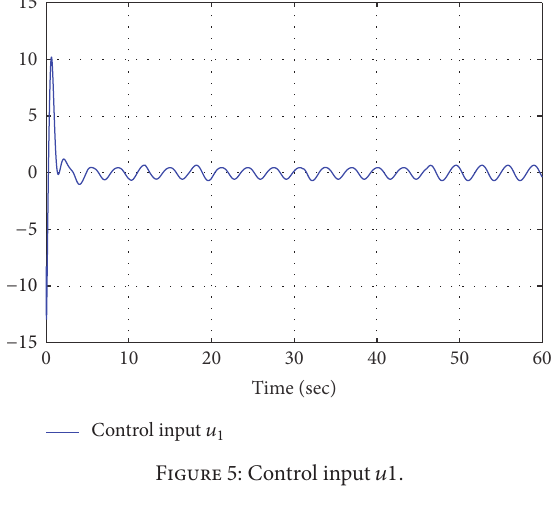
Figure 5: Control input 𝑢1 .